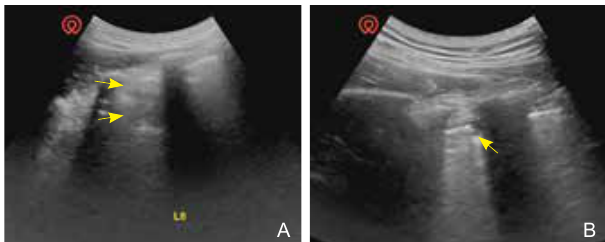
A Figure 2 Ultrasonic manifestations of lungs in asymptomatic confirmed patients with COVID-19. (A) Ultrasound showed that pulmonary consolidation was in zone 6 of the left lung (arrows); (B) Ultrasound showed that the B3-line was distributed in zone 5 of the right lung, which originated from the pleura line, and the pleura was uneven and thickened (arrow).